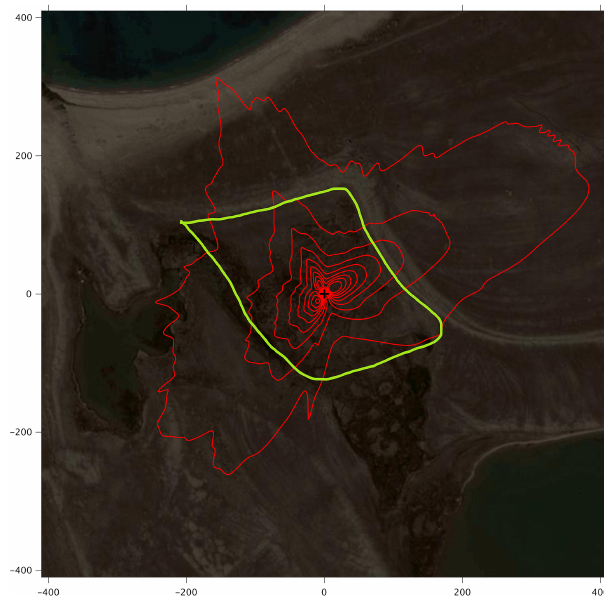
Figure 3. The footprint climatology with red contour lines 10%– 90%. The area within the green line marks the heart of the moss tundra. The scale ( m ) is shown on the outer borders of the picture (map source: https://Bing.com, Maxar Technologies).